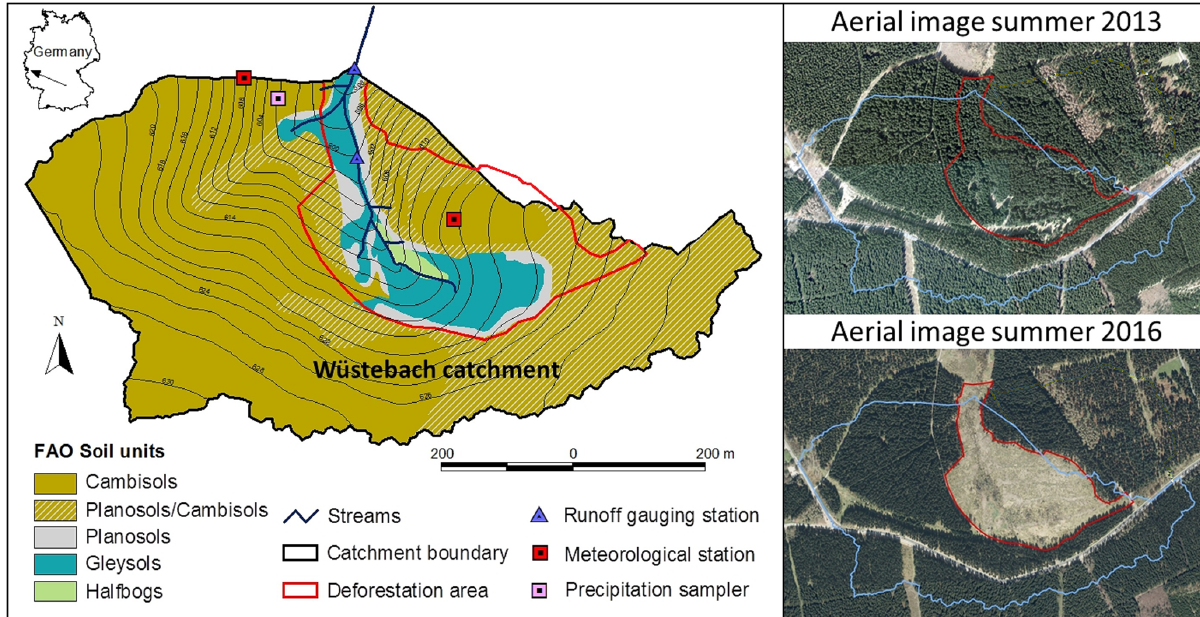
Figure 1. Map of the Wüstebach study catchment showing the spatial distribution of soil types. The riparian zone is defined by the parts of the catchment covered by Gleysols, Planosols and Halfbogs. The red line indicates the outline of the deforested part of the catchment, as can also be seen in the aerial images (© Google Earth, Maxar Technologies 2020) from 2013 and